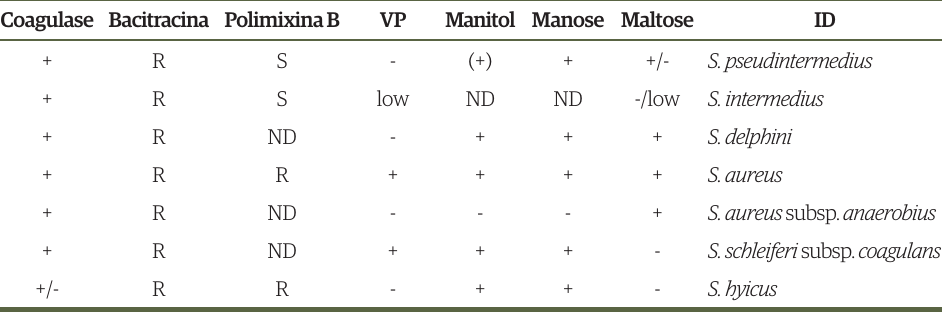
Table 1. Results in phenotypic identification of Staphylococcus coagulase-positive